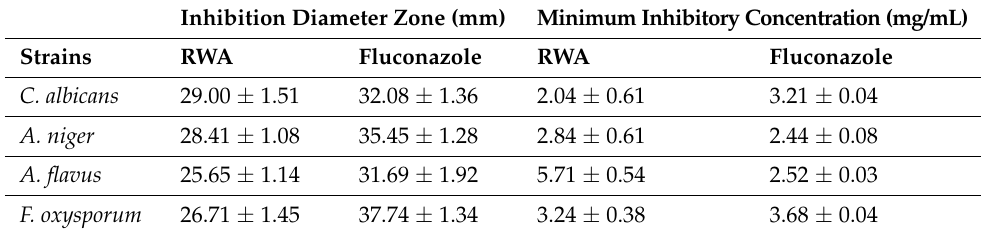
Table 5. MICs and inhibition diameters of RWA tested against fungal